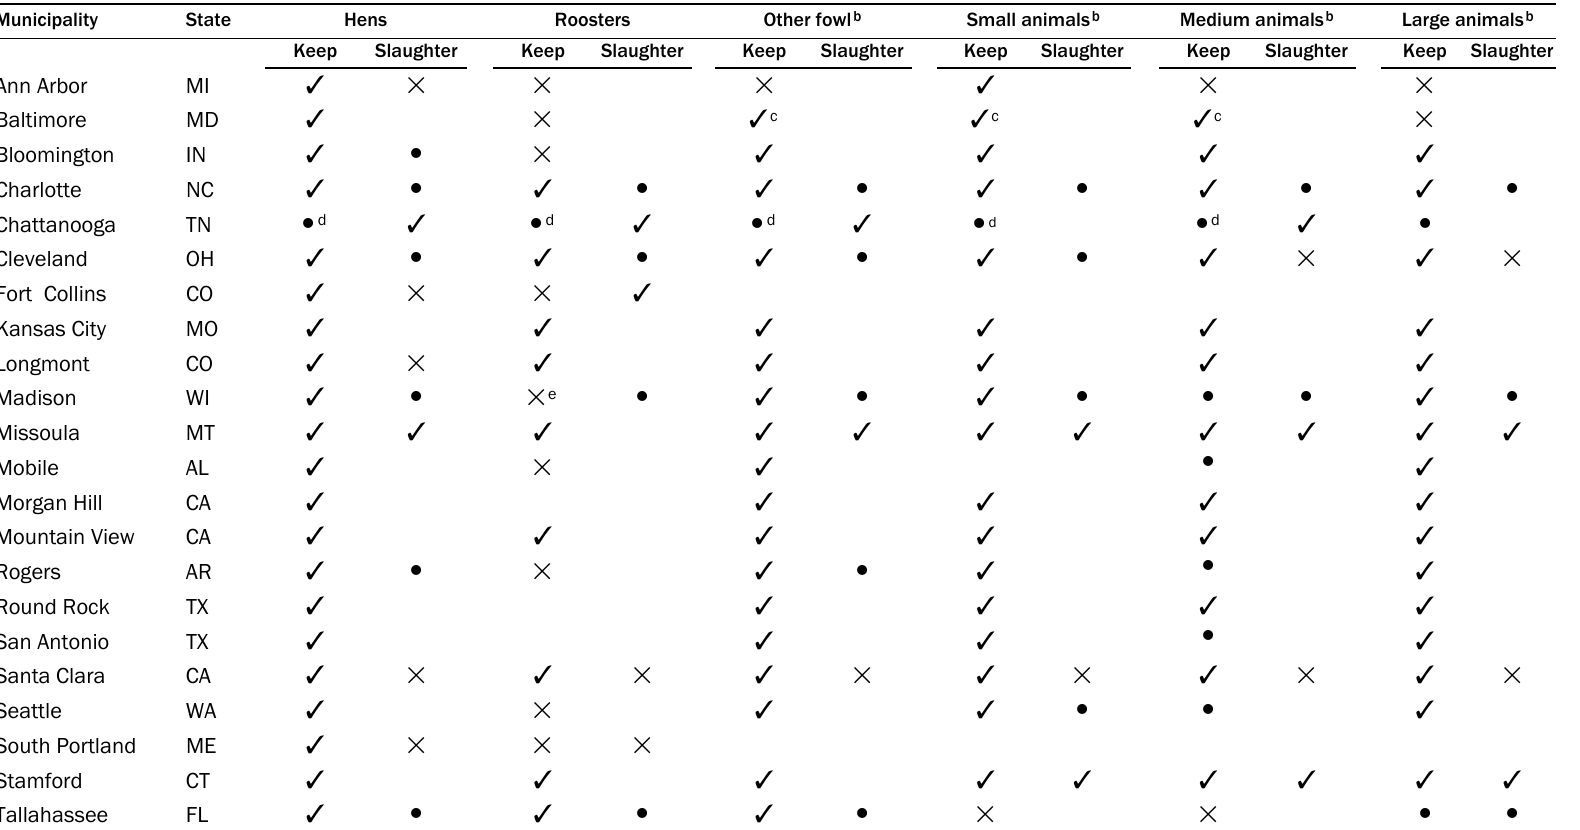
a The framework of this table and the data on livestock keeping are drawn from Table 1 in Butler (2012, p. 200). Honeybees are omitted here as bees are not subject to slaughter. b “Other fowl includes turkey, geese, ducks, etc. Small animals include rabbits. Medium animals include goats, pigs, sheep, etc. Large animals include cows, horses, alpacas, llamas, etc.” (Butler, 2012, p. 200). c Baltimore updated its health code in 2013 to expand the keeping of chicken hens, pigeons, rabbits, and small goats (Baltimore City Health Department, Office of Animal Control, 2013; Witt, 2013). d Allowed only on parcels of 5 or more contiguous acres (2 or more contiguous hectares).